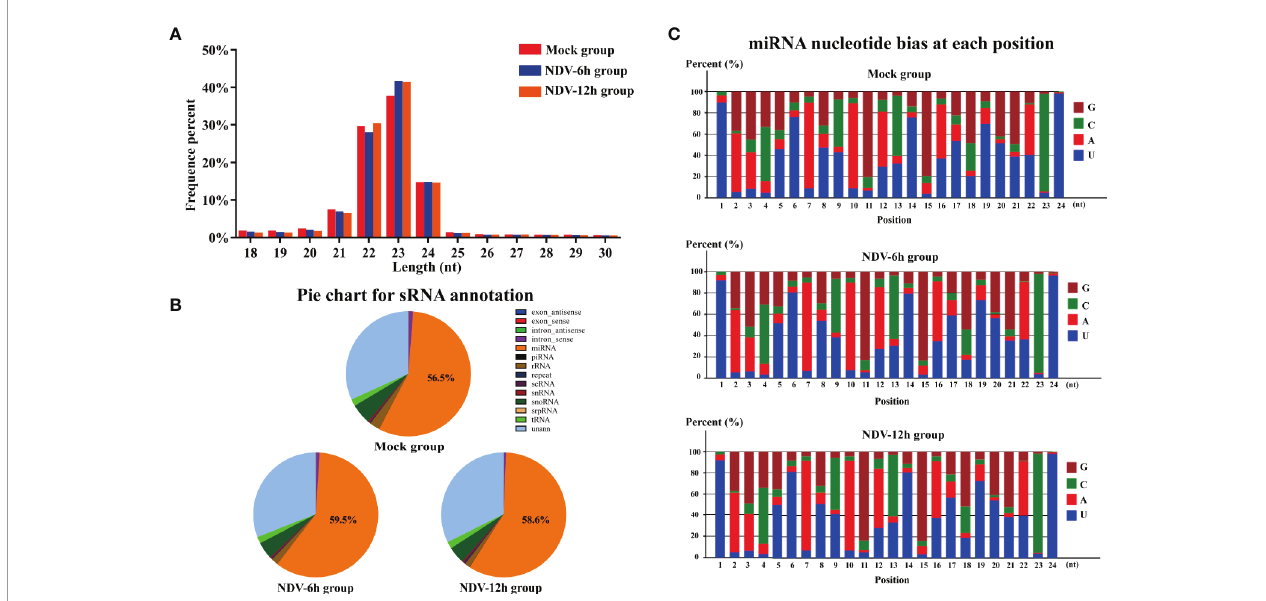
FIGURE 2 | Analysis of sRNA data of each groups. (A) Length distributions of the clean reads from each group. (B) Annotation of the clean reads for each group showing the quantity of sRNA components. (C) Analysis of the fi rst nucleotide bias in the identi fi ed known miRNAs of each